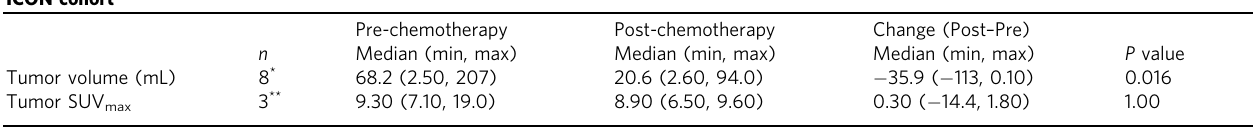
Table 2 Changes in tumor volume and SUV max in ICON patients with abnormal nodes post-therapy. ICON